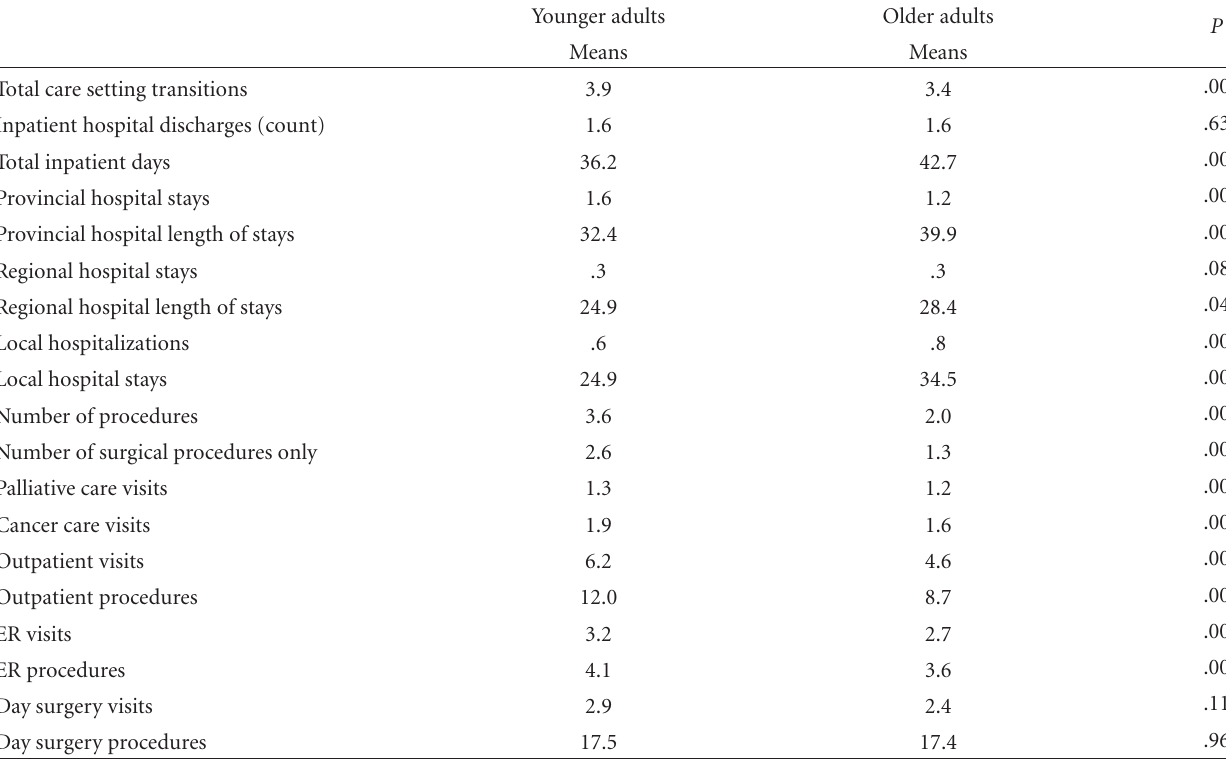
Table 1: Comparisons across younger and older subjects ( N =